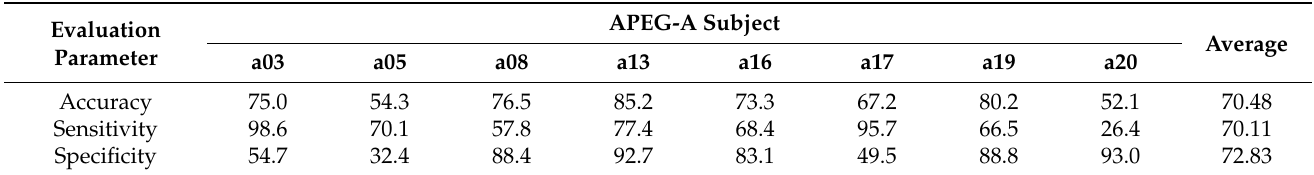
Table 8. Leave-one-subject-out cross-validation classification performance using a PAED-APEG-A 60 s time window based on 8~50 Hz frequency range and SVM